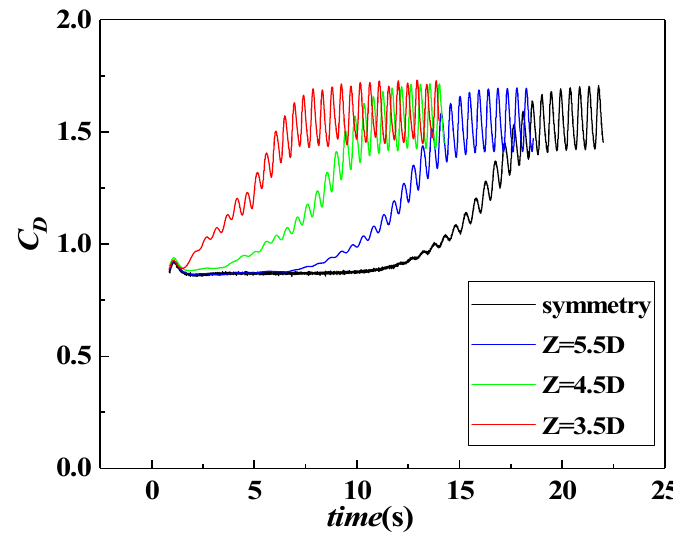
ff erent free surface heights Z ( Re = 3.5 × 10 4 ).